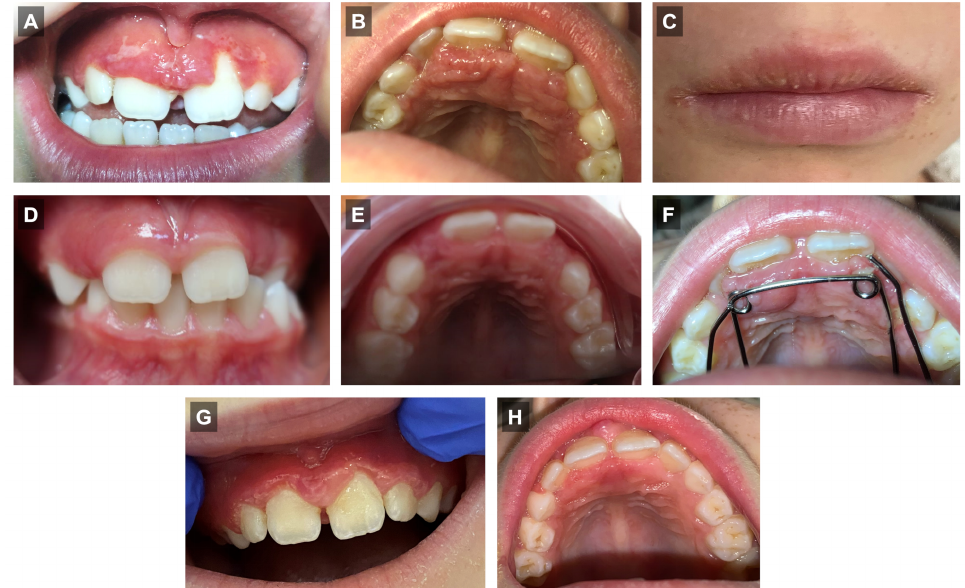
Figure 1. OFG clinical observations. ( A – C ) Gingival and labial lesions occurring after the placement of an interceptive orthodontic (quad-helix) appliance. Gingival examination before ( D , E ) and on the day of quad-helix placement ( F ). ( G , H ) Gingival examination 3 months after daily corticoid